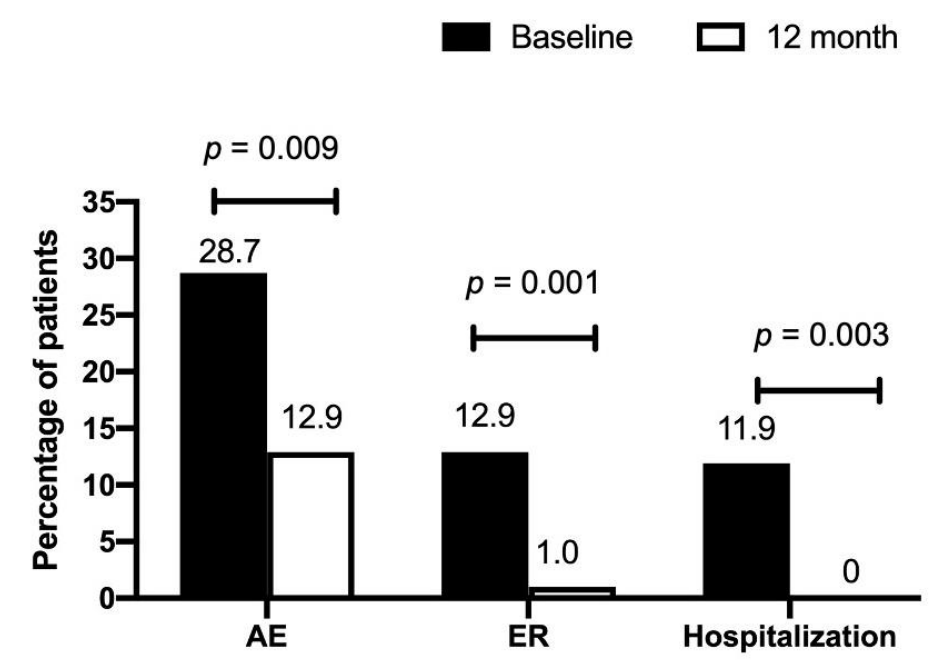
Figure 3. Percentage of acute exacerbation (AE), emergency room (ER) visits, and hospitalizations in patients with asthma at baseline and after 12-month treatment.